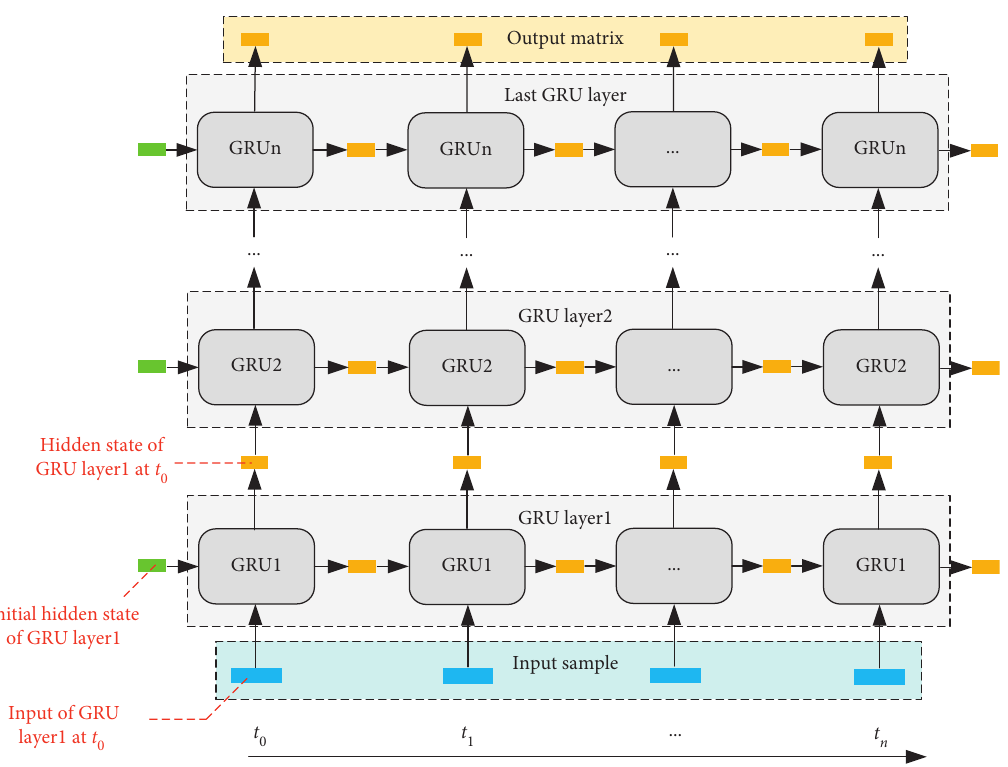
Figure 2: Structure of stacked GRU along the time axis.